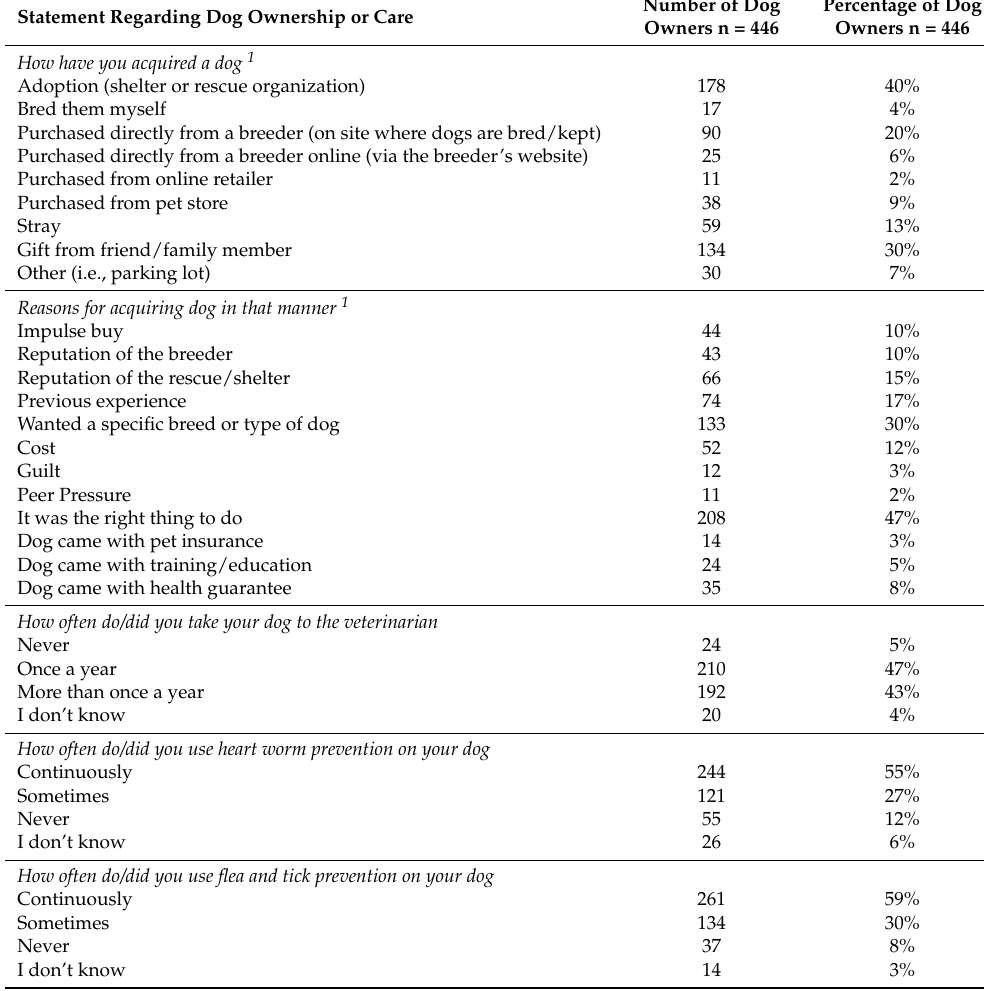
Table 4. Percentage of respondents who have a dog or had a dog in the past 5 years who selected the response to specific dog ownership and care questions (n =